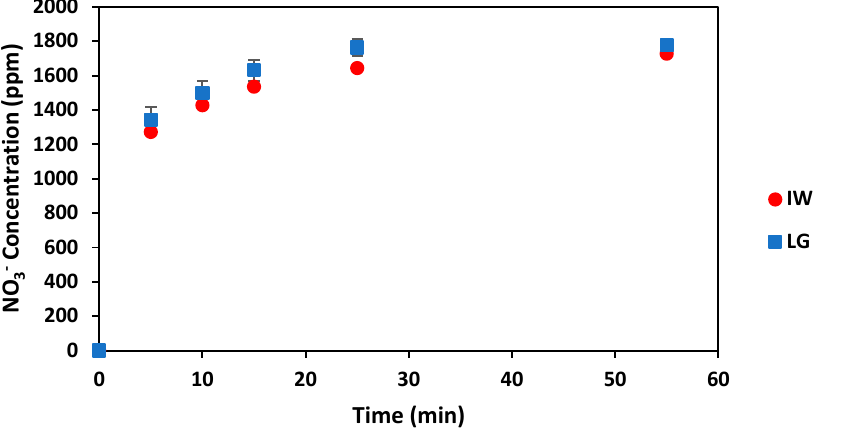
Figure 3. Concentration of NO 3 − released during the nutrient release tests for produced slow-release fertilisers (5 wt% alginate in LG and 3.3 wt% IW) over 55 min. The error bars indicate the standard deviation from triplicate experimental runs.